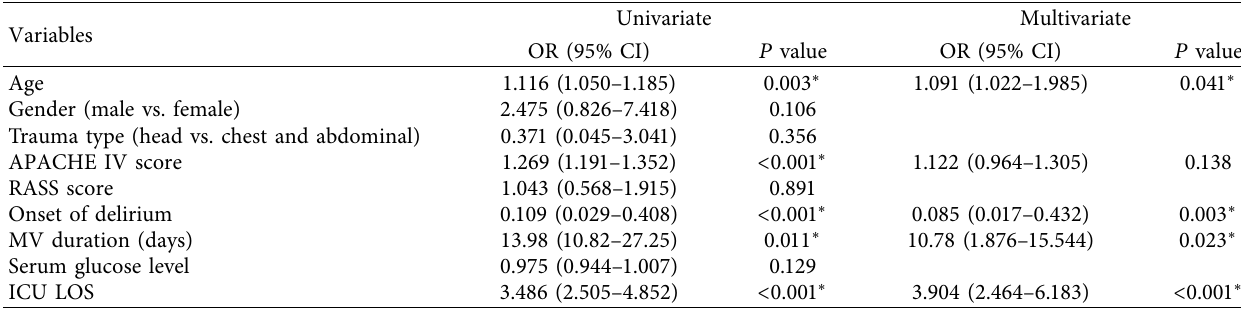
Table 2: Univariate and multivariate logistic regression analysis to determine the independent factors associated with VAP in patients with delirium.